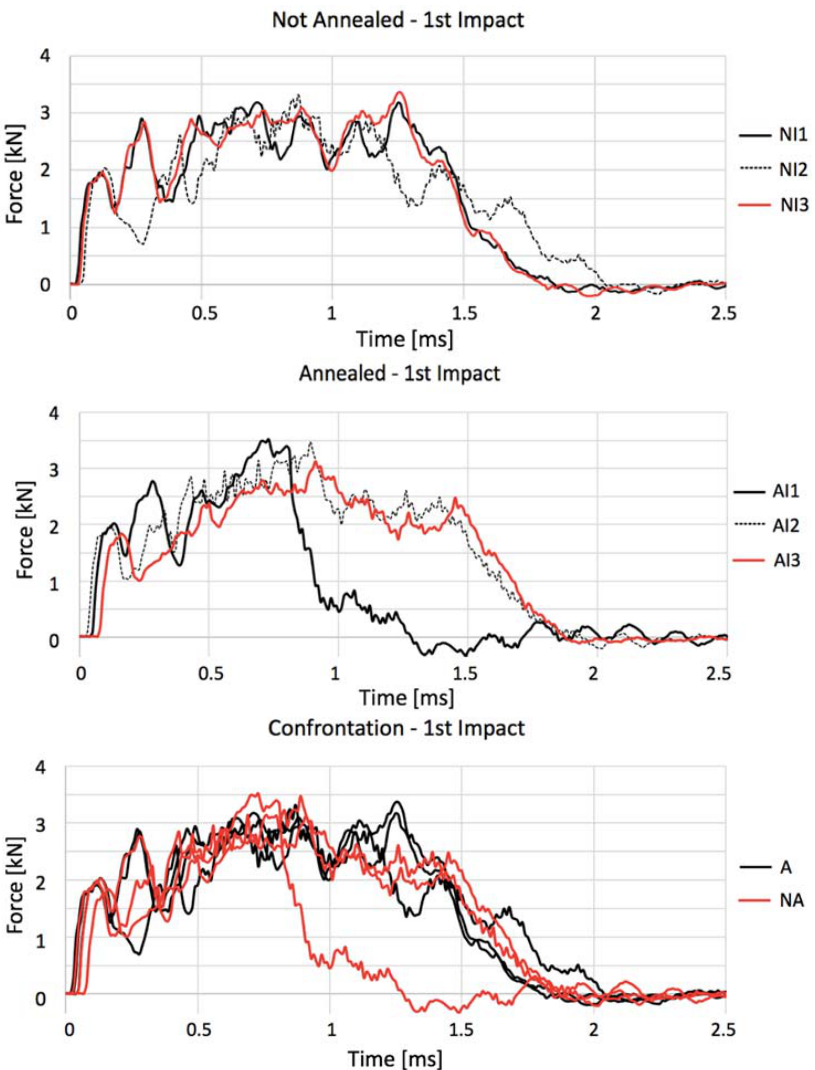
Figure 12. Force–time curves describing not annealed (NI1, NI2, and NI3) and annealed (AI1, AI2, and AI3) impacted specimens along with their comparison.